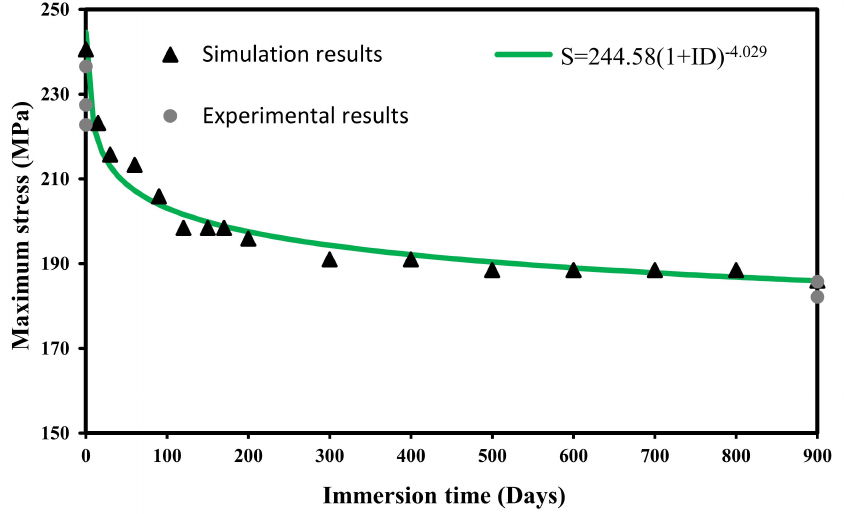
Figure 11. Maximum stress against immersion time: numerical predictions and experimental results for 0 and 900 immersion